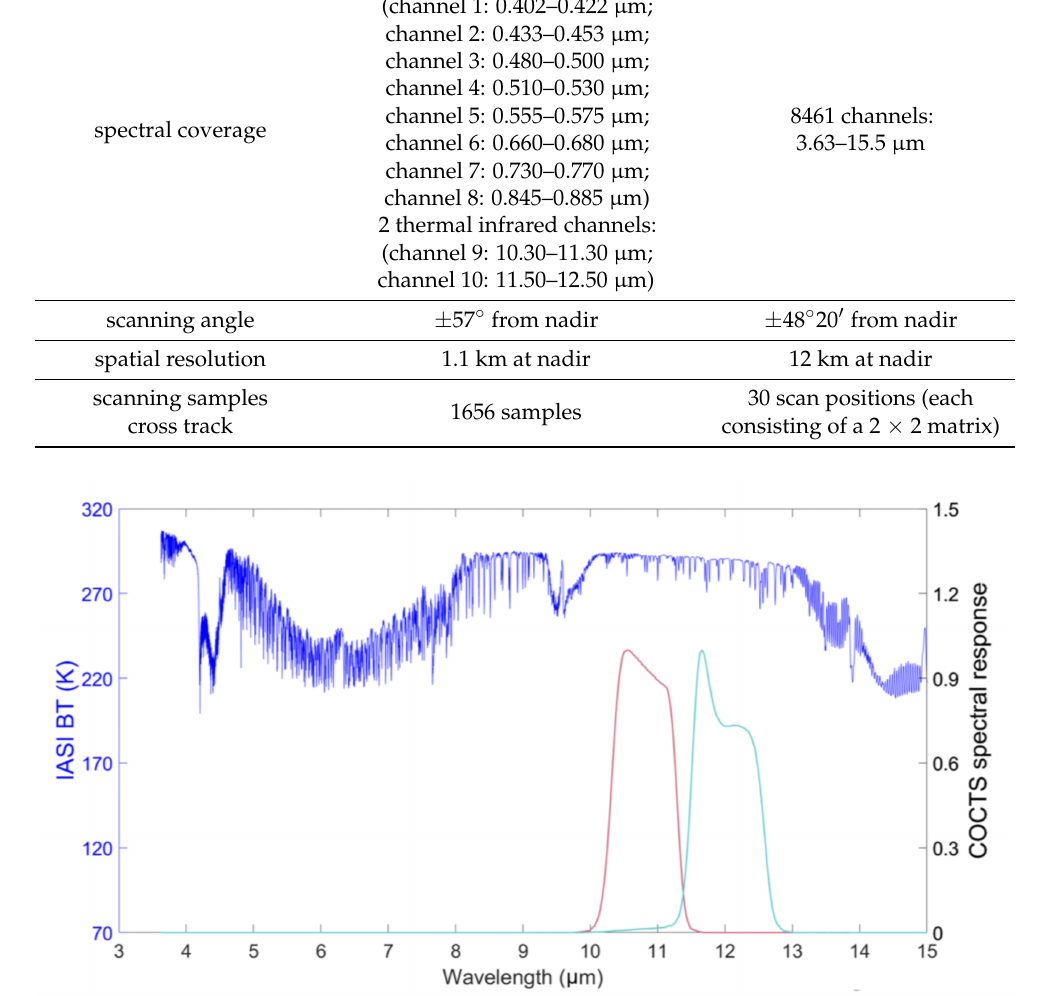
Figure 1. The IASI measured spectral brightness temperatures (BTs) for 8461 channels with the spectral response functions of the HY-1C COCTS thermal infrared channels (red: 11 µ m channel; green: 12 µ m